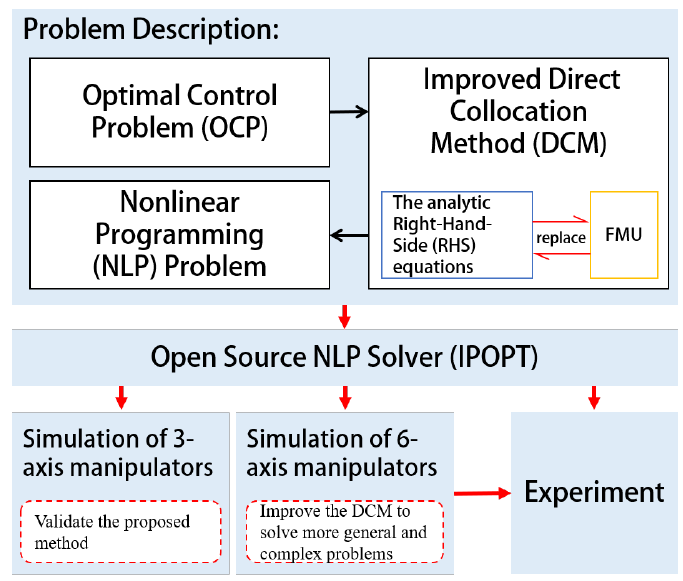
Figure 1. Paper flow